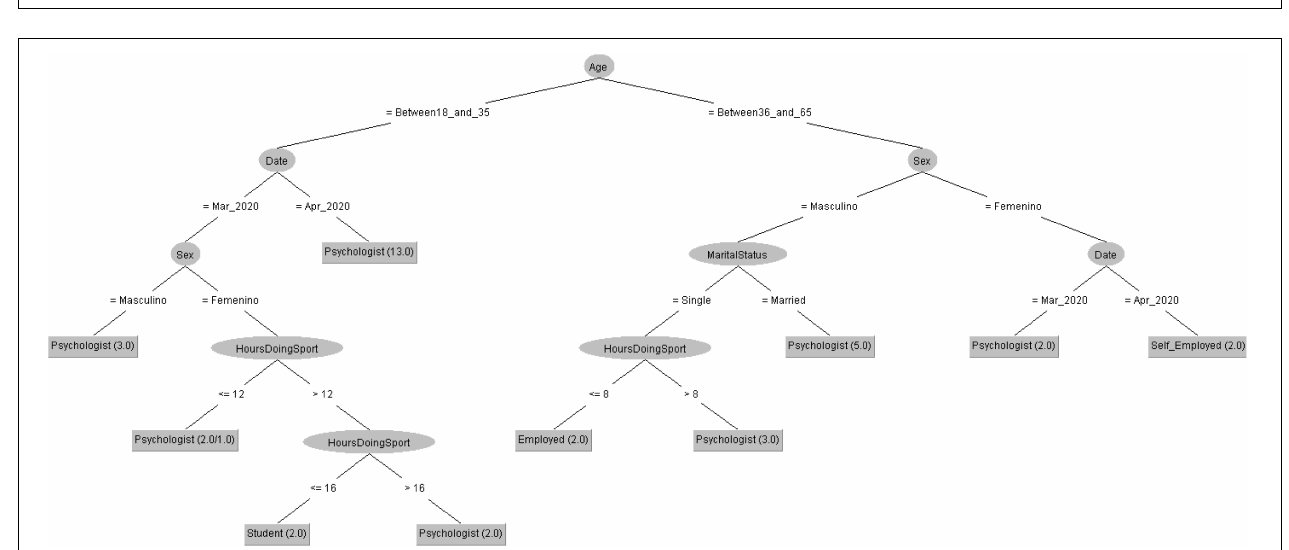
FIGURE 7 | Profession of people taking the STAI questionnaire in 2019 decision tree.